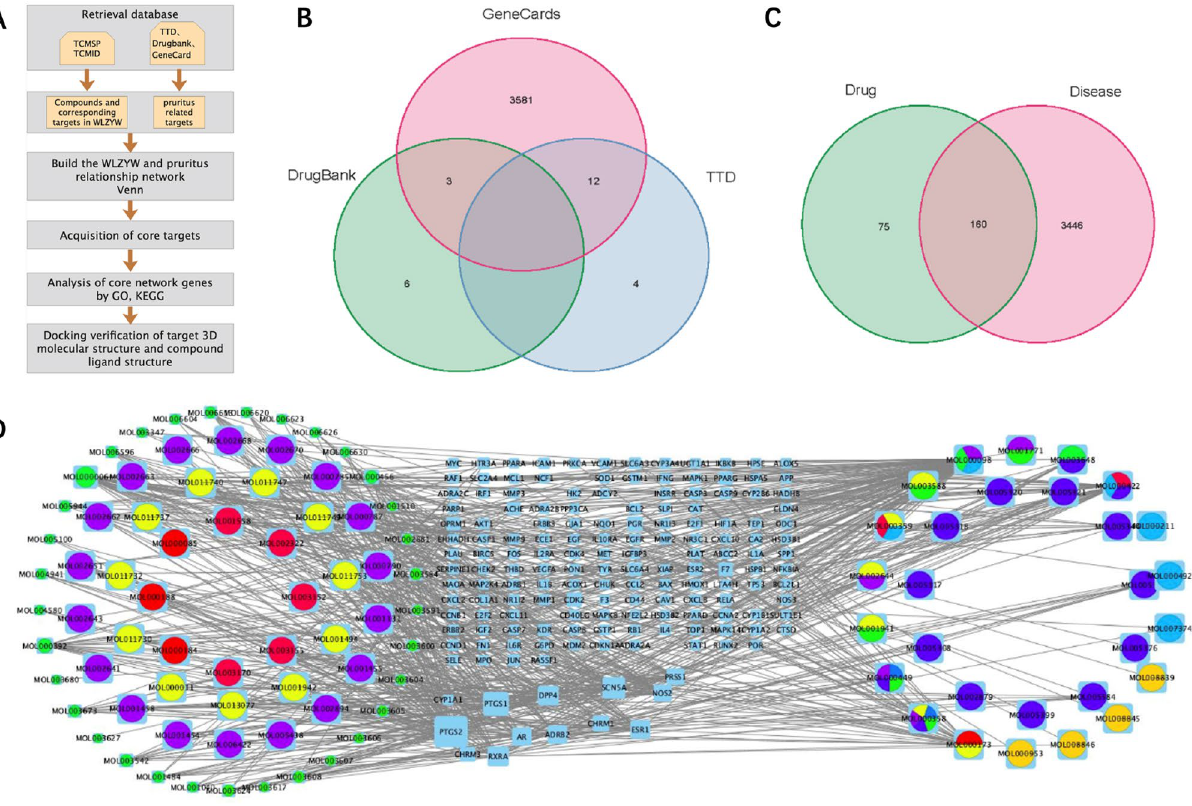
Figure 1. Regulatory networks of WLZYW components correspond to potential pruritus targets. ( A ) Schedule of Network Pharmacology. ( B ) Venn Diagram of Pruritus Targets. ( C ) The intersection of WLZYW components targets and pruritus targets. ( D ) WLZYW potential targets pool network. The light blue quadrilateral in the center represents 160 coincident targets of WLZYW and pruritus. The circles on each side represent the compounds, one color is one component. Visualization via Cytoscape